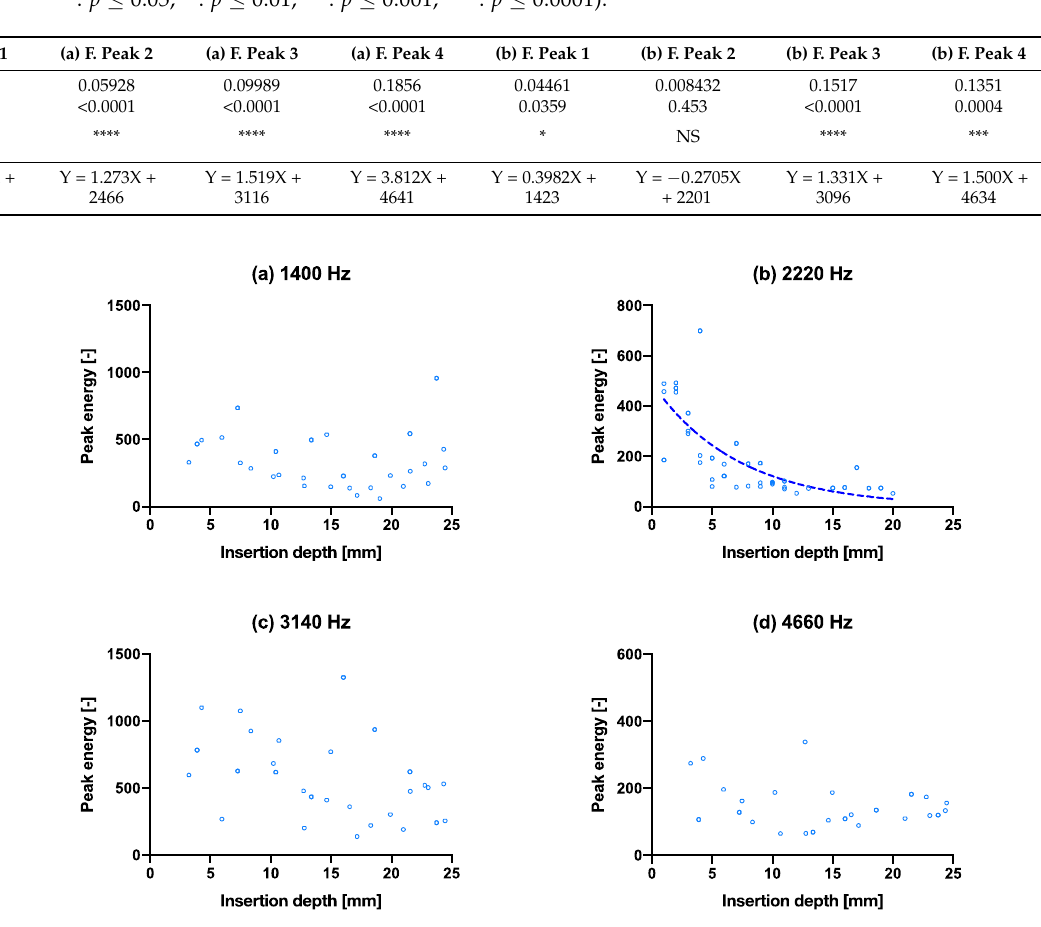
Table 3. Simple linear regression of figure in the Section 4 frequency peaks 3 and 4 for both small and large broaches show correlating increasing pitch frequency with insertion depth (NS: p > 0.05,